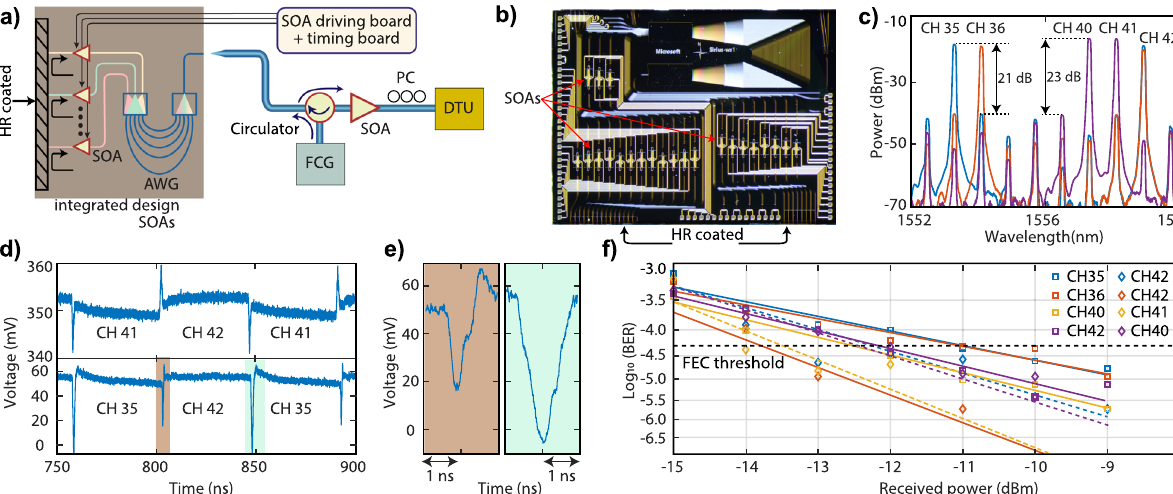
Fig. 4 Sub-ns optical circuit switching (OCS) and data transmission using on-chip SOAs and on-chip AWG along with soliton microcomb. a Schematic of the setup used to perform the OCS and data transmission. The multi-wavelength optical carriers, generated via the frequency comb generator (FCG), are coupled to an InP chip containing an AWG and SOAs via an optical circulator. The coupled optical carriers are aligned to the AWG by changing the temperature of InP chip. The aligned carriers are transmitted to integrated SOAs; if one of them is biased, then the AWG channel (waveguide) connected to that particular SOA is re fl ected from the high-re fl ection coated facet of the chip while non-biased SOAs block the light. The re fl ected-back channels are coupled back via an anti-re fl ection coated optical fi ber for encoding the information using the data transmission unit (DTU). b Microscope image of PIC showing the SOAs (red arrows) and AWG. c Optical spectrum of comb channels with different spacing while switching after the InP chip indicating more than 20 dB isolation with adjacent AWG channels (cross talk). The red curve shows CH 36 and 42 with 4.8 nm wavelength spacing, the blue curve CH 35 and 42 (5.6 nm) and the purple curve CH 40 and 41 (0.8 nm). d The sub-ns wavelength switching between two different comb channels using on-chip SOAs. The overshoot in the switching signal is due to impedance mismatch between the high-speed radio-frequency (RF) probes and the on-chip electrodes. This effect can be minimized by optimizing the drive signal. e The left and right fi gures show the zoomed-in view of switching signals between two different comb channels (CH35 and CH 42). f The bit error ratio (BER) performance of the 25 GBd NRZ PIC-based switching system for different combinations of two comb